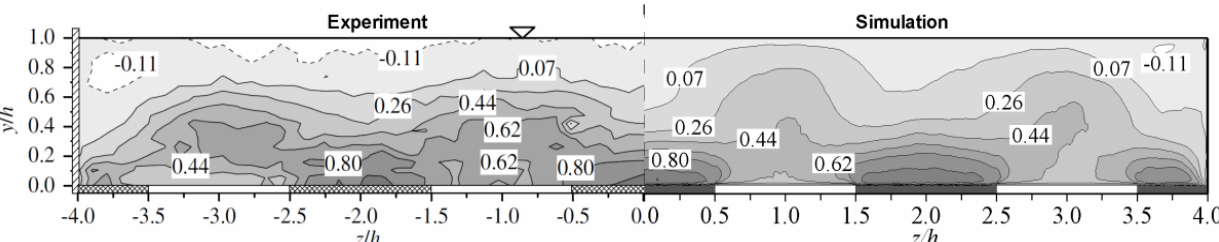
Figure 7. Contours of measured ( left ) and simulated (right ) shear stress, normalized on the squared global shear velocity, in the cross-section.